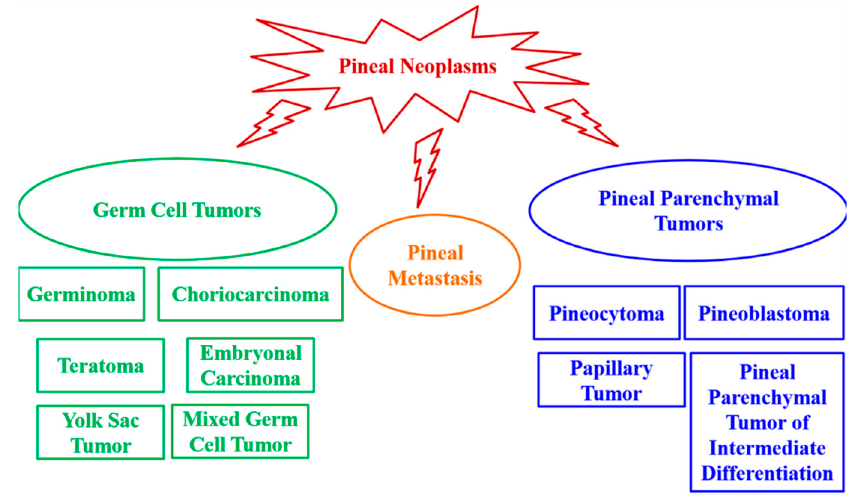
Figure 2. Pineal tumor classification.